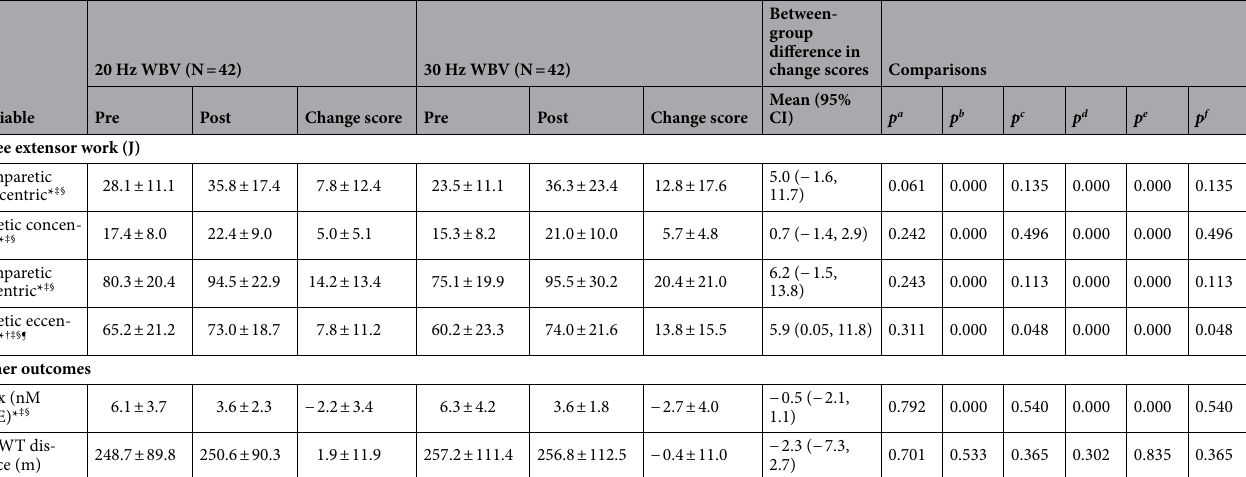
Table 2. Outcome measurements (Intention-to-treat analysis). *Significant time effect ( p < 0.05). † Significant group × time interaction effect ( p < 0.05). ‡ Significant within-group comparison (20 Hz WBV group) ( p < 0.05). § Significant within-group comparison (30 Hz WBV group) ( p < 0.05). ¶ Between-group comparison of change score ( p < 0.05). a Baseline comparisons (independent t-test). b Time effect (ANOVA). c Group × time interaction effect (ANOVA). d Within-group comparison (20 Hz WBV group) (paired t-test). e Within-group comparison (30 Hz WBV group) (paired t-test). f Between-group comparison of change score (independent